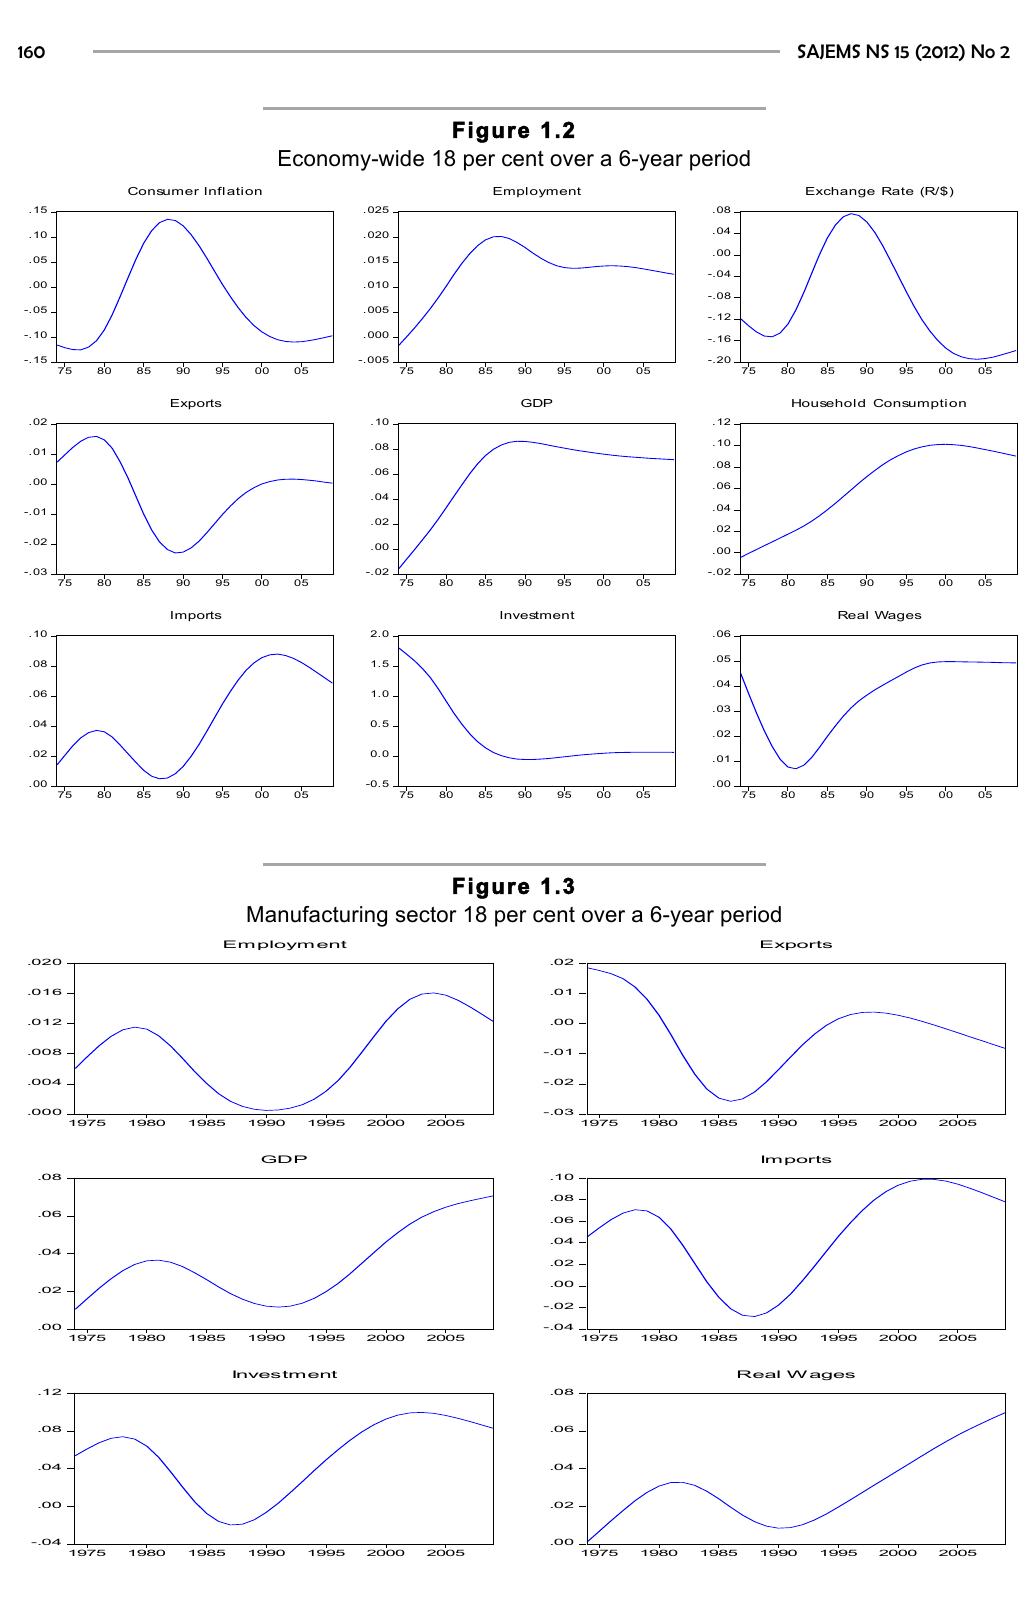
Economy-wide 18 per cent over a 6-year period